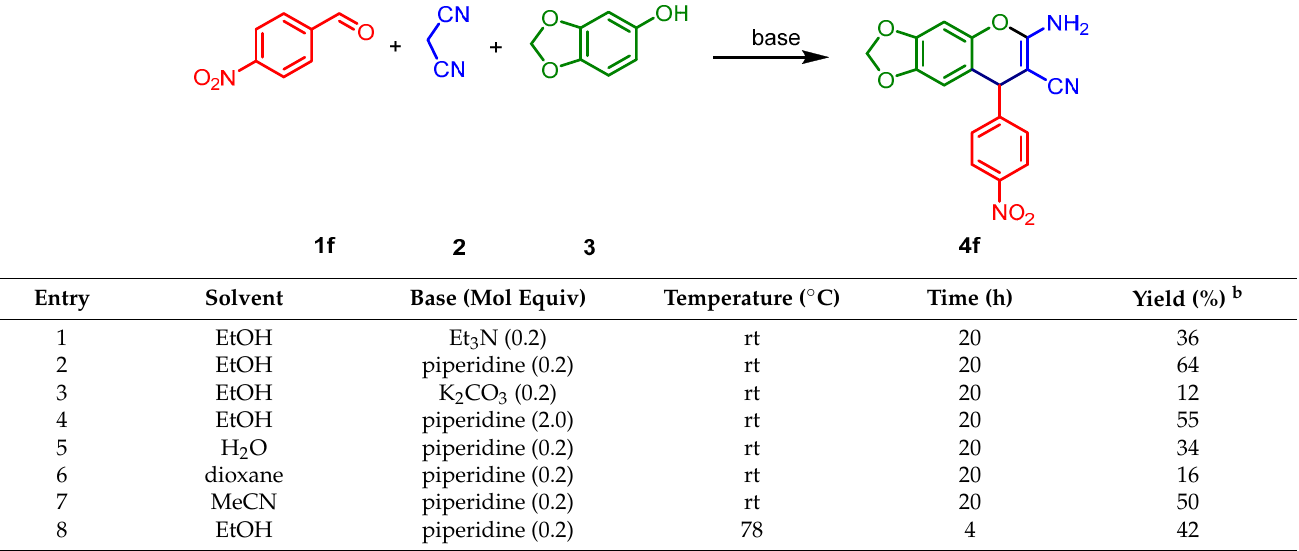
a All reactions were carried out with an equimolecular mixture of 1f , 2 and 3 . b Isolated yield after purification by column